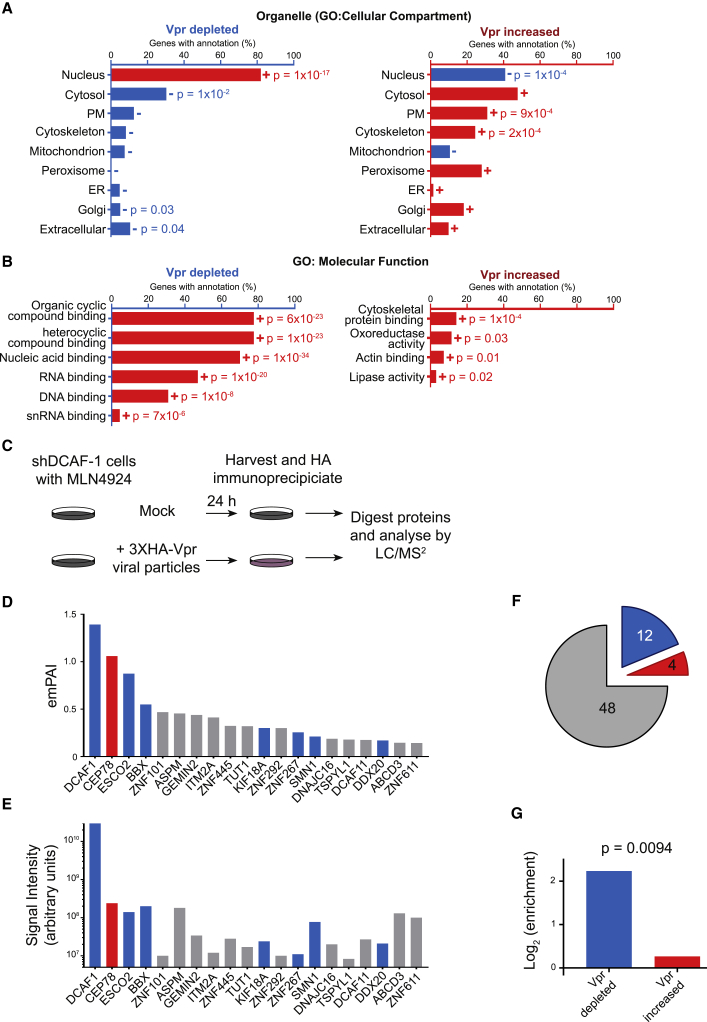
Co-immunoprecipitation MS to Identify Direct Targets for Vpr-Mediated Degradation(A) Defined groups of Vpr-depleted and increased proteins were subject to gene ontology enrichment analysis and compared with a background of all proteins quantitated in these experiments. Gene Ontology (GO) cellular compartment enrichment analysis results were manually curated for 9 commonly used organelle level classifications, shown here. Bars shown in red with a + symbol were enriched compared with the expected number through chance, whereas bars in blue (−) were de-enriched. Where p < 0.05, the associated p value represents the results of a Fisher’s exact test with Bonferroni correction.(B) GO: molecular function analysis of the Vpr-depleted and -increased proteins, in this case showing all terms enriched within each group with p < 0.05 in a Fisher’s exact test with Bonferroni correction.(C) Graphical summary of the IP-MS experiment. All cells were stably transduced with a ShDCAF1 vector as described earlier. MLN4924 is a pan-Cullin inhibitor.(D) 20 most abundant proteins identified by coIP determined by number of unique peptides, normalized as a proportion of the maximum possible peptide count for each protein (exponentially modified protein abundance index [emPAI]). Proteins falling within the defined list of 302 Vpr-depleted and 413 Vpr-increased proteins are highlighted in blue and red, respectively.(E) The same 20 proteins with signal intensity rather than peptide count shown.(F) Pie chart indicating the overlap between the proteins co-immunoprecipitated with Vpr and the defined list of 302 Vpr-decreased (blue) and 413 Vpr-increased proteins (red) and proteins detected but falling into neither list (gray).(G) Bar chart showing the enrichment of Vpr-depleted and Vpr-increased proteins within proteins co-immunoprecipitated with Vpr compared with the expected numbers of proteins that would be co-immunoprecipitated from each group by chance. The p value was calculated by Fisher’s exact test of a 2 × 2 contingency table (Vpr-depleted or -increased, identified by coIP or not identified).